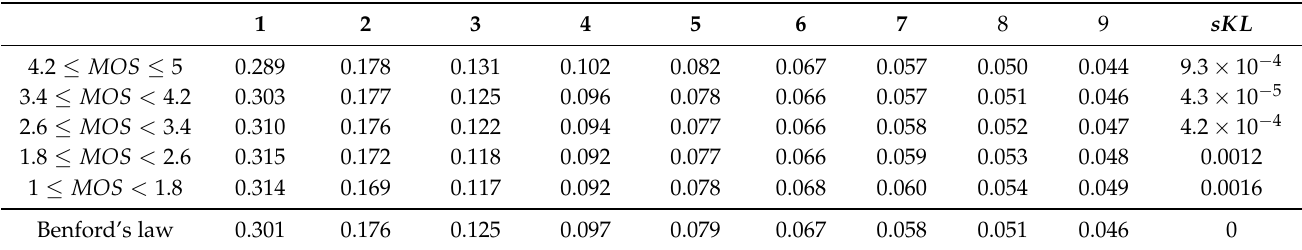
Table 2. Mean FDD of DCT coefficients in KonIQ-10k [21] with respect to different MOS intervals. In KonIQ-10k [21], lowest possible image quality is represented by MOS = 1.0, while MOS = 5.0 stands for the highest possible image quality. In the last column, the symmetric Kullback–Leibler ( sKL ) divergences between the actual FDD and Benford’s law distribution are